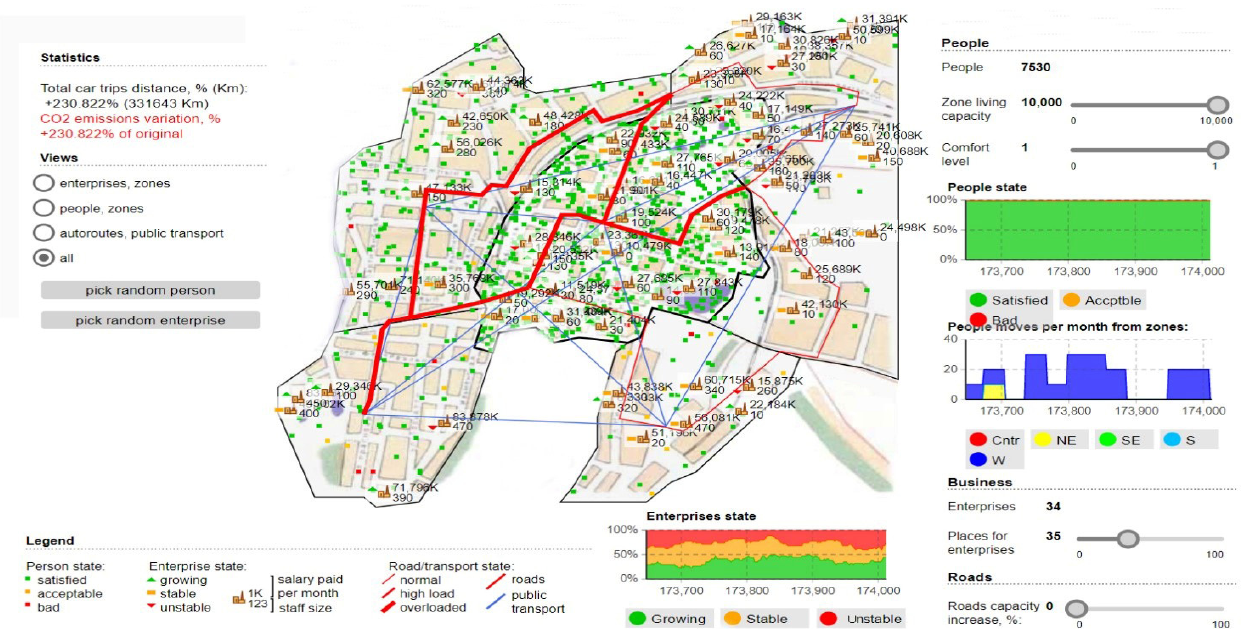
Figure 6. Simultaneous scenario showing the instability of transit routes and the degree of congestion created, as well as CO 2 emissions.